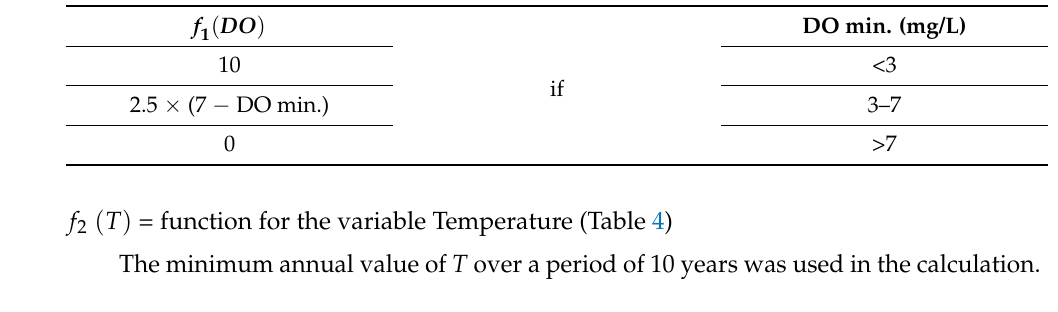
Table 4. The ranges used to assign values for seawater temperature.